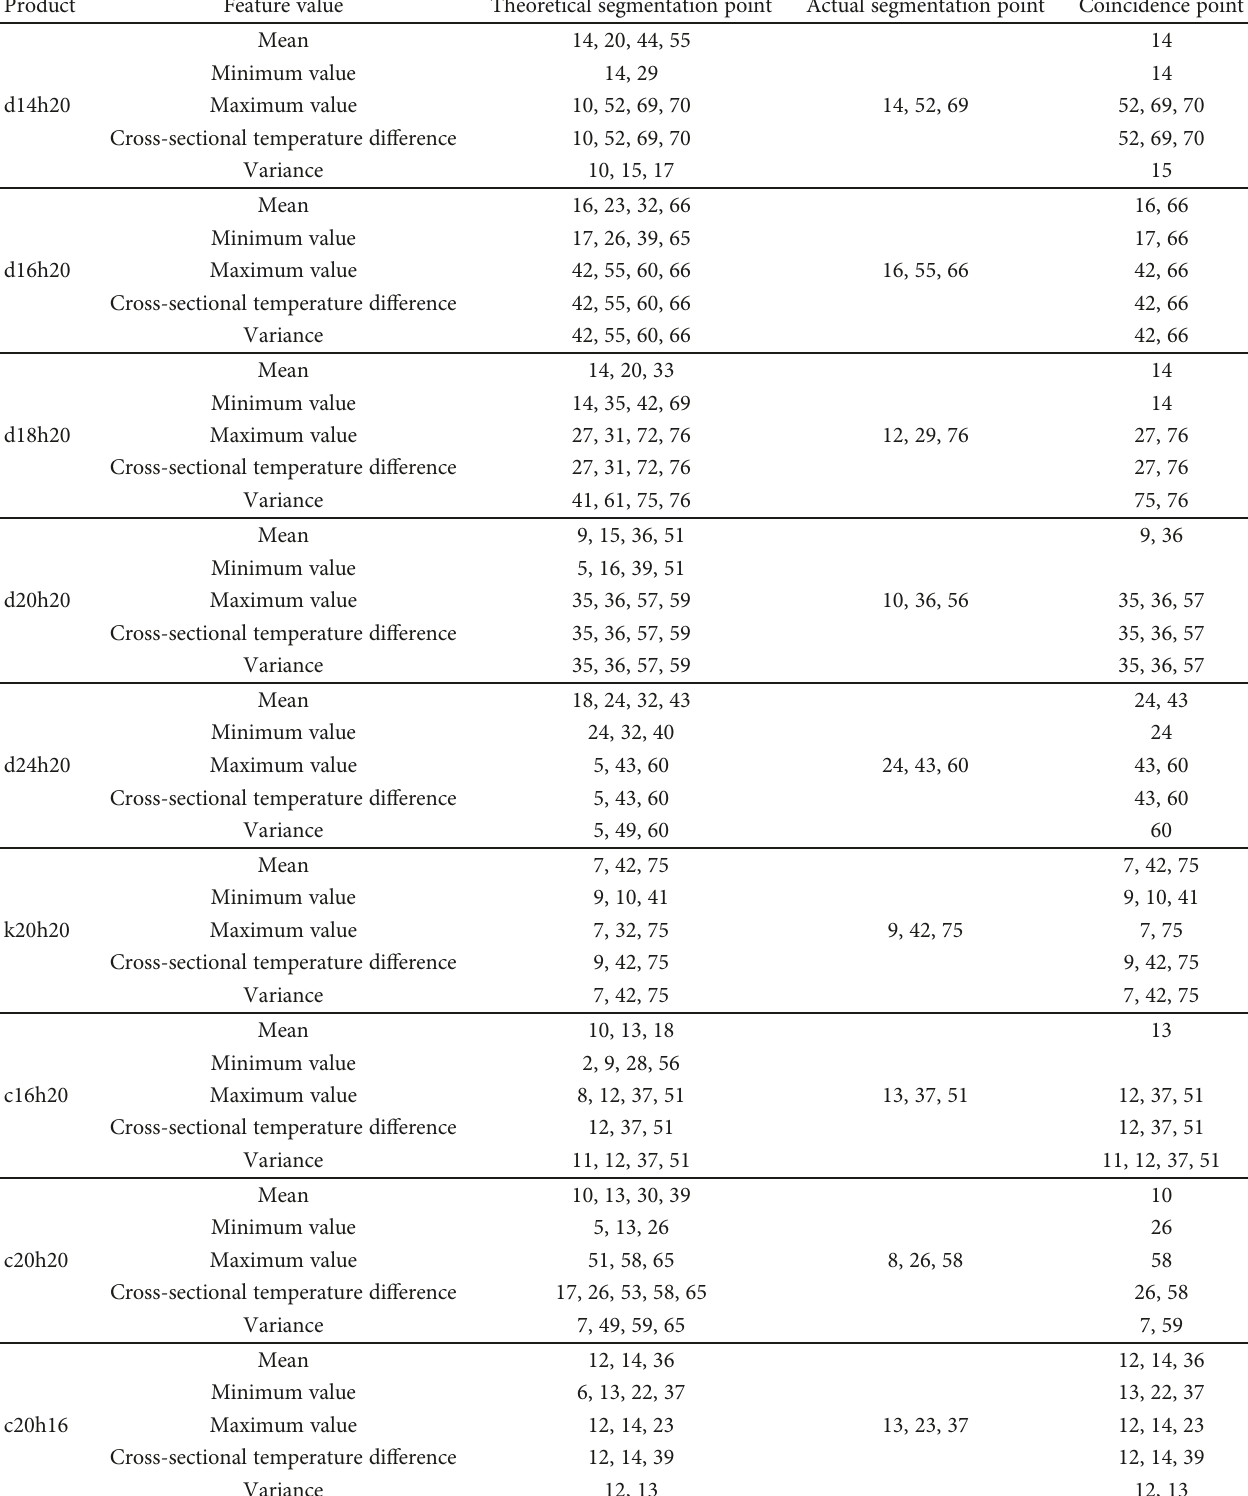
Table 2: The actual initial stage and the theoretical initial stage of 10 pairs of